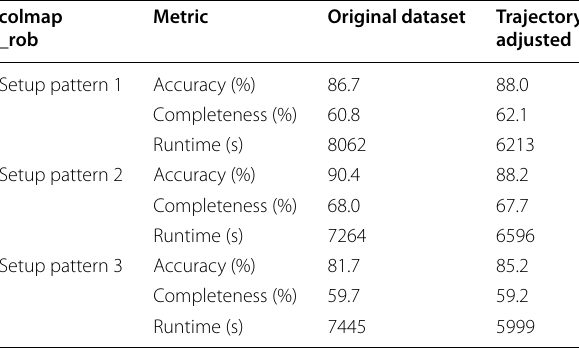
Table 5 Reconstruction performance comparison results of all three setup patterns by colmap_rob before and after removing the transition images